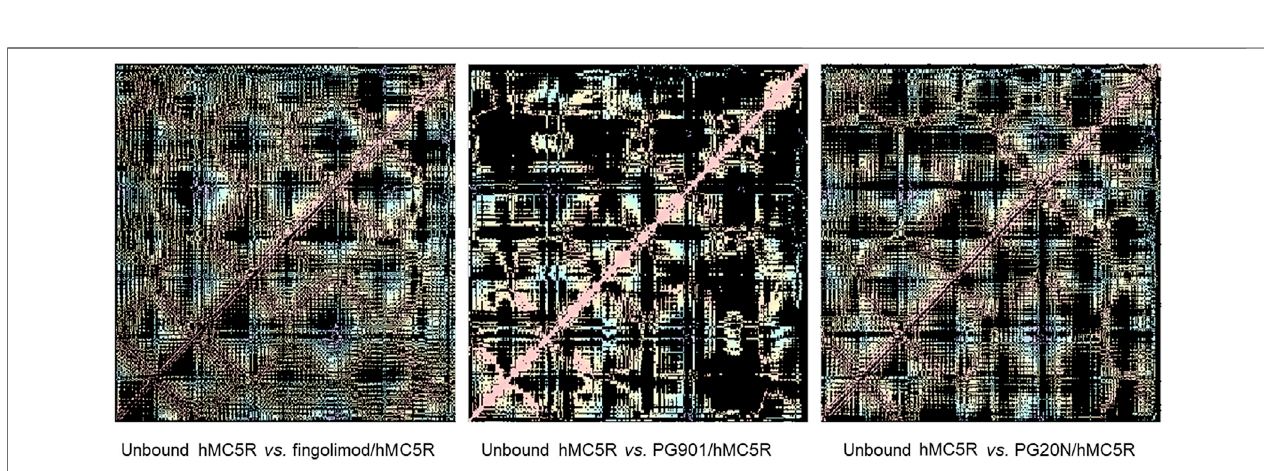
FIGURE 9 | Differences in residue-residues contact maps in hMC5R bound to fi ngolimod and selective agonist (PG901) and antagonist (PG20N).